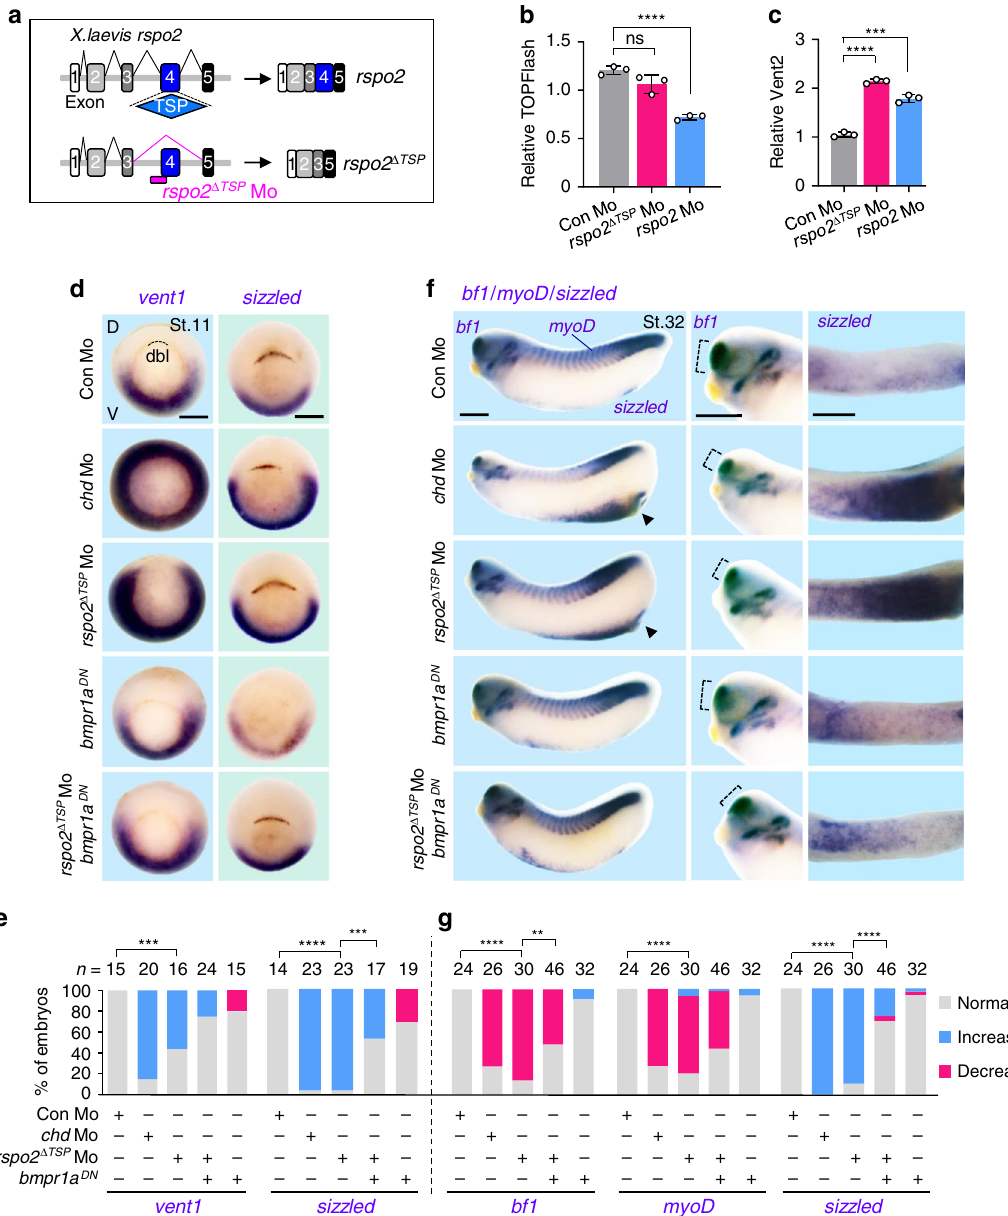
Fig. 5 Loss of Rspo2-TSP1 domain activates BMP signaling in Xenopus development. a Scheme for rspo2 Δ TSP splicing Mo in Xenopus laevis . b TOPFlash assay in Xenopus laevis neurulae (St.15) injected radially at 4-cell stage with reporter plasmids and Mo as indicated. Data are displayed as mean ± SD; ns, not signi fi cant, **** P < 0.0001 from two-tailed unpaired t -test. n = 3 biologically independent samples. c BMP-reporter ( vent2 ) assay in Xenopus laevis neurulae (St.15) injected radially at 4-cell stage with reporter plasmids and Mo as indicated. Data are displayed as mean ± SD; *** P < 0.001, **** P < 0.0001 from two-tailed unpaired t -test. n = 3 biologically independent samples. d – g In situ hybridization of BMP4 targets vent1 and sizzled in Xenopus laevis . Embryos were injected radially and equatorially at 4-cell stage as indicated. Gastrulae (St.11) ( d ) and quanti fi cation ( e ); Tadpoles (St. 32) ( f ) and quanti fi cation ( g ). Dashed lines, dorsal blastopore lip (dbl) ( d ) or bf1 expression ( e ); D, dorsal; V, ventral. For f , left, lateral view; middle, magni fi ed view of head; right, magni fi ed view of ventral side. ‘ Increased/Decreased ’ represents embryos with signi fi cant expansion/reduction of sizzled or vent1 signals toward the dorsal/ventral side of the embryo ( e ), or with signi fi cant increase/decrease of the signal strength ( g ). ns, not signi fi cant. n , number of embryos. Scale bar, 0.5 mm. Scoring of the embryos for quanti fi cation was executed with blinding from two individuals. For e , g , ** P < 0.01, *** P < 0.001, **** P < 0.0001 from two-tailed χ 2 test comparing normal versus increased. Data are pooled from at least two independent